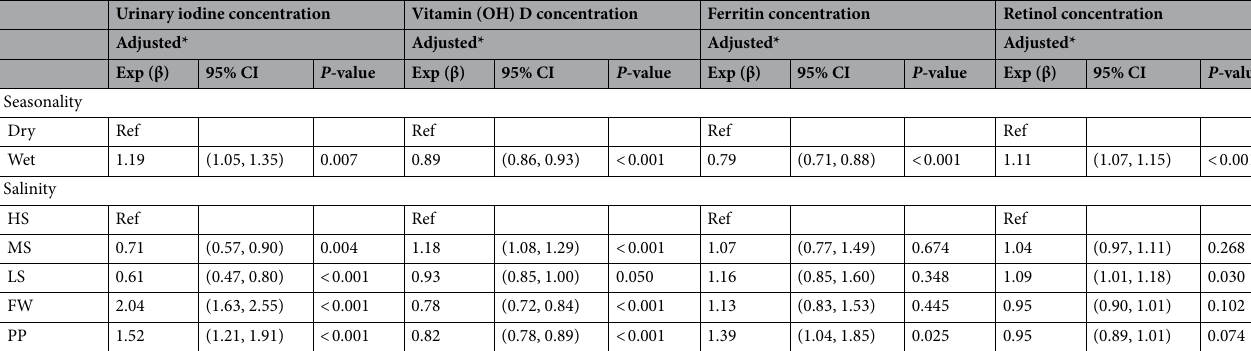
Table 2. Factors affecting micronutrient status in adolescent girls. CI Confidence Interval, Ref . Reference. Mixed-effects linear regression analysis adjusted for each other independent variables and other variables (age, BMI, dietary diversity score, wealth quintiles). All biomarkers (urinary iodine, vitamin D, serum retinol and ferritin) were log-transformed; the co-efficient is expressed as the Exp (β) / Geometric Mean Ration (GMR) with 95% CIs. Statistical significance has been considered for 5% level of significance.